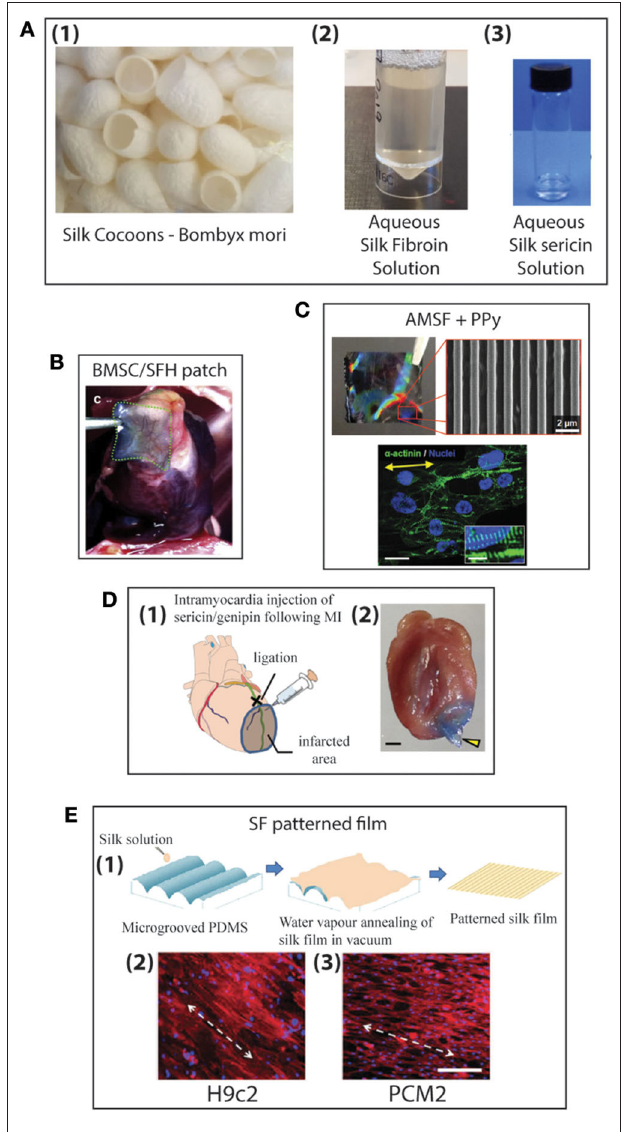
FIGURE 8 | (A) Production of aqueous silk solutions from silk cocoons (1), Fibroin solution (2), Sericin solution (3) (B) Histological image of MI zones of heart for Bone marrow mesenchymal stem cells/silk fibroin/hyaluronic acid (BMSC/SFH) patch shown after 8 weeks of infarction (233). (C) Nanopatterned silk substrate of nanopatterned acid-modified silk fibroin (AMSF) with deposited poly(pyrrole) (PPy) (1 cm 2 ). SEM image of AMSF + PPy nanopatterned substrate. Cardiomyocytes fluorescently stained for α -actinin (green) and nuclei (blue). Cells on nanopatterned substrates exhibit elongated and aligned morphologies. Yellow arrows indicate the direction of the nanopattern. Scale bar: 25mm; inset 10mm (234). (D) Genipin crosslinked sericin hydrogel (1) schematic showing the anatomical site (black cross) of the occlusion of left anterior descending coronary artery (LAD) (green line), the corresponding infarcted myocardial region (shaded area), and the injection site of the sericin/genipin hydrogel delivered via a syringe. (2) Macroscopic view of a wild-type heart with a layer of myocardium at the LAD-supplied area cut to open showing an in situ forming of genipin-crosslinked sericin hydrogel (yellow arrowhead). Scale bar, 1mm (235). (E) Schematic representation of the fabrication of patterned silk films using microgrooved PDMS molds (1).